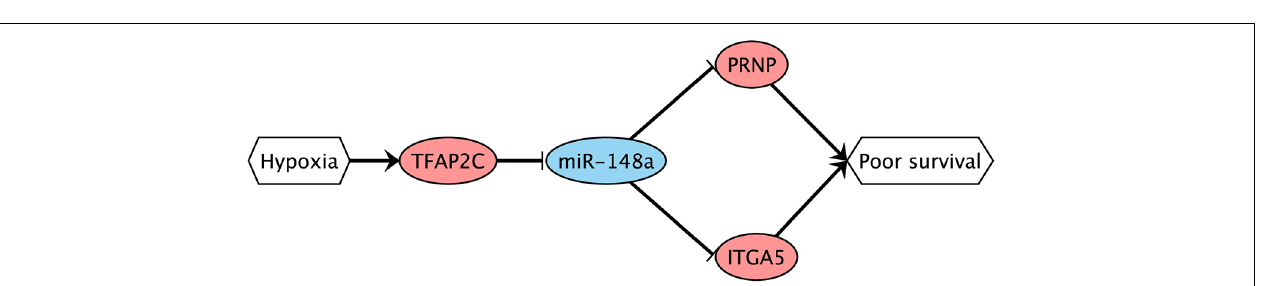
Frontiers in Genetics |